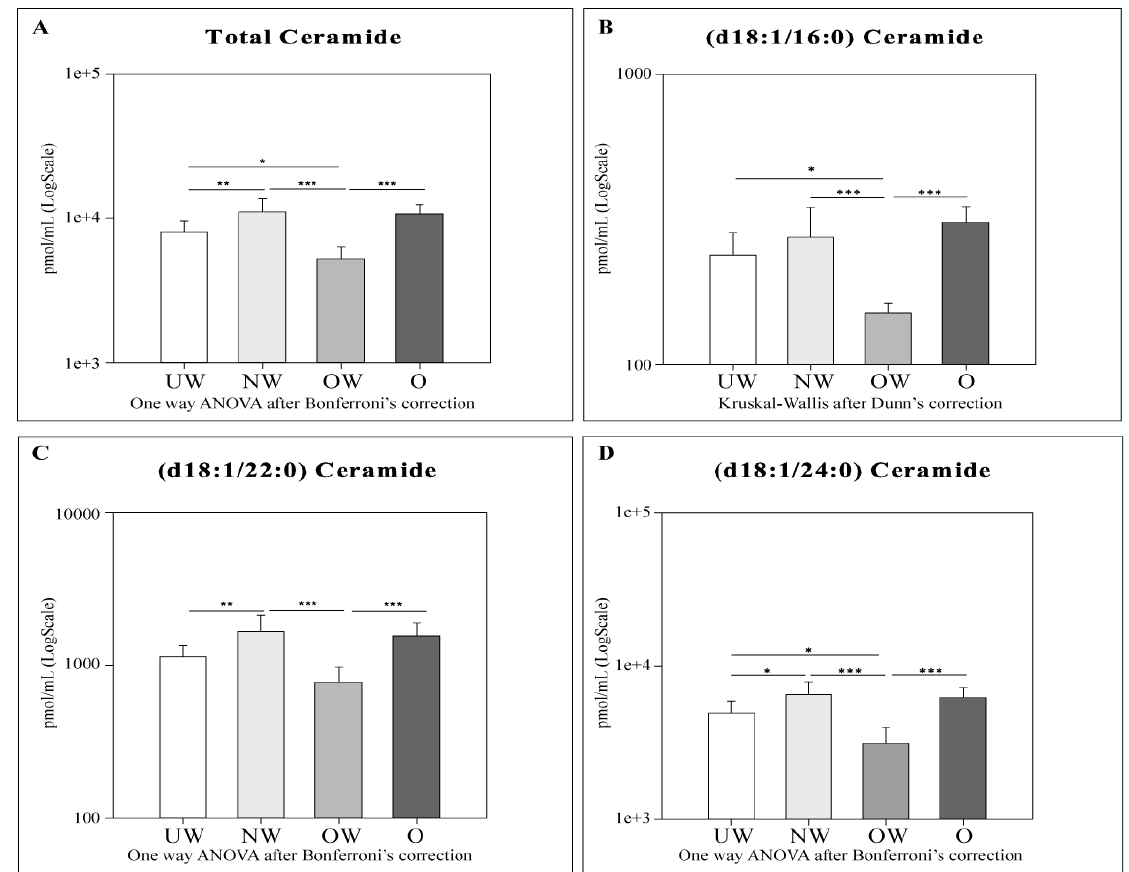
Figure 2. LC-MS results for total ceramides ( A ), Cer (d18:1 / 16:0) ( B ), Cer (d18:1 / 22:0) ( C ), and Cer (d18:1 / 24:0) ( D ). Data are expressed as pmol / mL in Log scale; p values are expressed as * p -value < 0.05, ** p -value < 0.01, and *** p -value < 0.001.